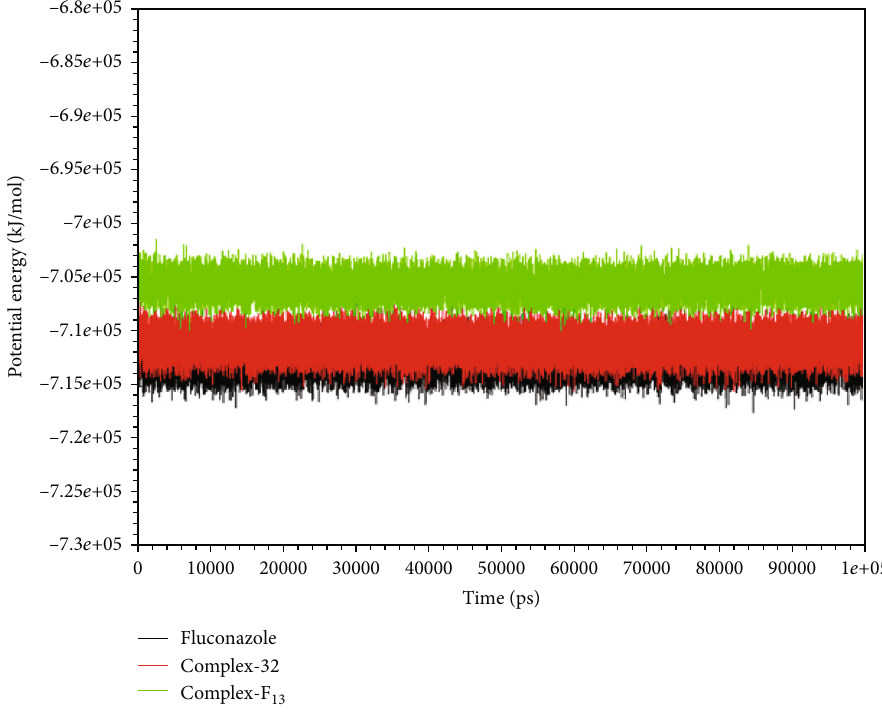
Figure 12: Potential energy curve during 100ns simulation ( fl uconazole: protein- fl uconazole complex, complex-32: protein-ligand complex, complex-F13: protein'-ligand